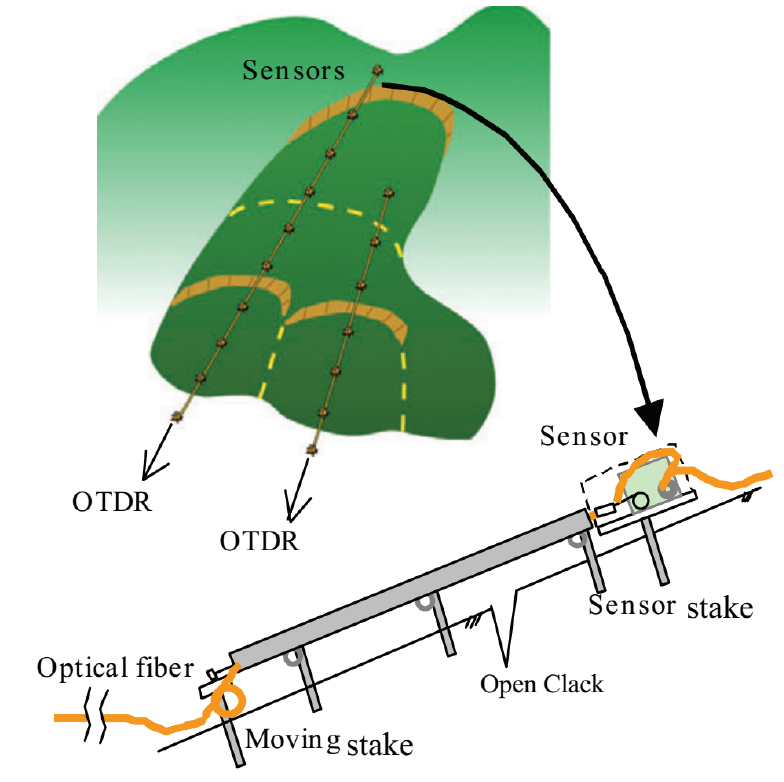
Figure 13. Installation scheme of a distributed strain sensing system for landslide monitoring proposed by Higuchi et al.